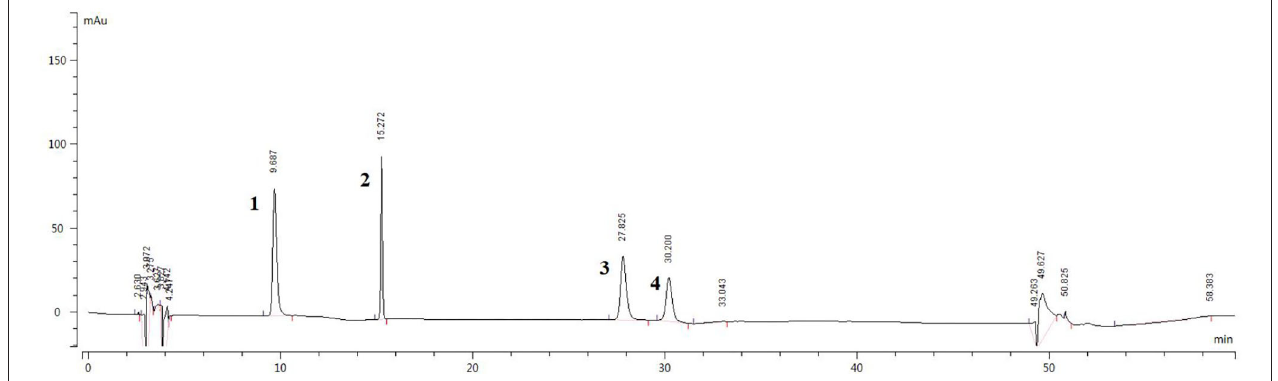
FIGURE 2 | HPLC chromatogram of the standard compounds. 1. Vasicine, 2. Vasicinone, 3. Harmaline, and 4. Harmine.